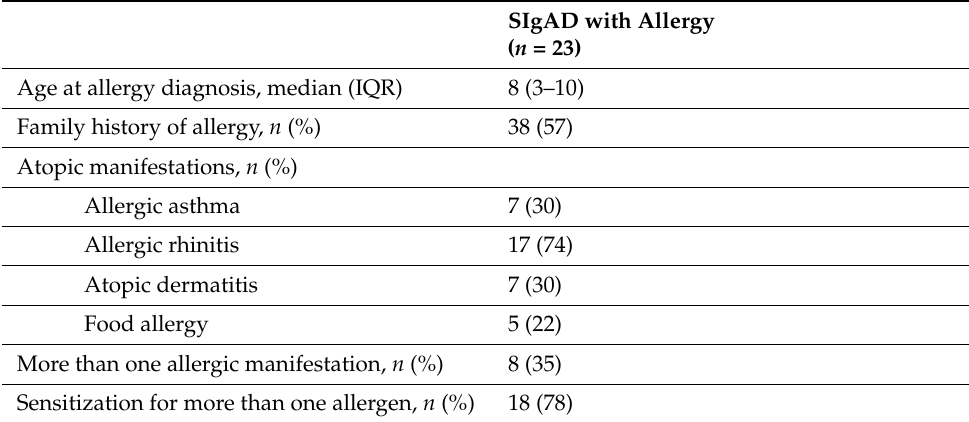
Table 3. Allergic manifestations in the 23 SIgAD children and adolescents with allergy.